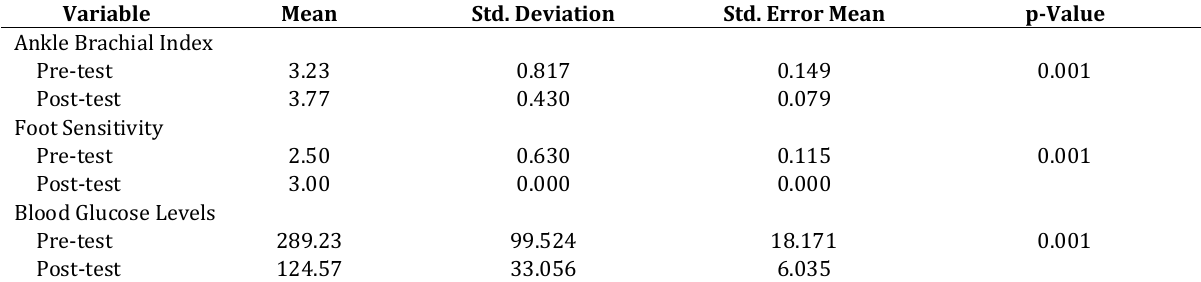
Table 2. The dispute of the ankle brachial index, foot sensitivity, and. the blood glucose levels before and after the intervention of diabetic foot spa